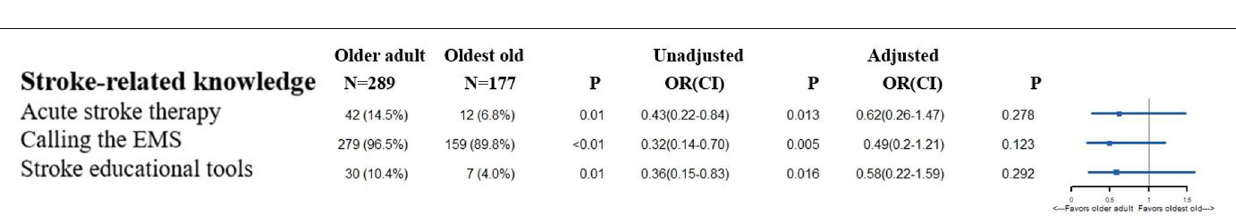
FIGURE 4 | Differences in the knowledge of stroke symptoms and risk factors between older adults and the oldest old (age cut-off 75 years). OR, Odds Ratio; CI, Confidence Interval. In the multivariable logistic regression analysis, we adjusted gender, educational background, smoking history, drinking habit, hypertension, diabetes, myocardial infarction, prior stroke, dyslipidemia, cancer history, atrial fibrillation. The OR means the comparison between the older adults and oldest old (oldest old vs. the older adults).